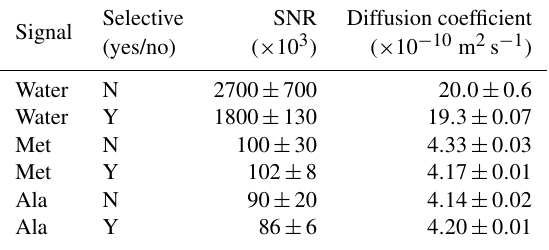
Table 1. Non-selective (BPP-LED) and selective (Sel-BPP-LED) diffusion experiments are compared. Water (4.8ppm), the methio- nine methyl signal of MAS (2.0ppm), and the alanine methyl sig- nal of MAS (1.4ppm) were used for these analyses. SNR was cal- culated using the first increment in the diffusion series. Diffusion coefficients were extracted from the diffusion plots using Eq. (1). The diffusion time was the same for all experiments ( (cid:49) = 250ms). A single Sel-BPP-LED experiment was used, with the water and MAS signals exposed to gradient strengths ranging from 1%–60% and 1%–95% of maximum, respectively. Reported SNR values are the mean ± standard deviation of triplicate measurements.